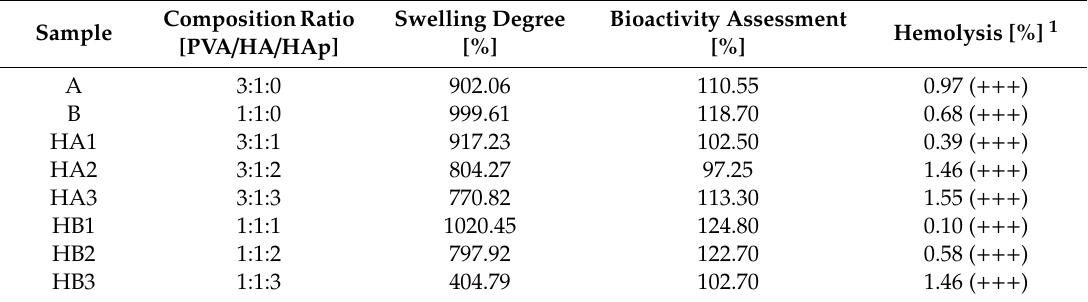
Table 1. Results of swelling degree, bioactivity assessment, and the test of